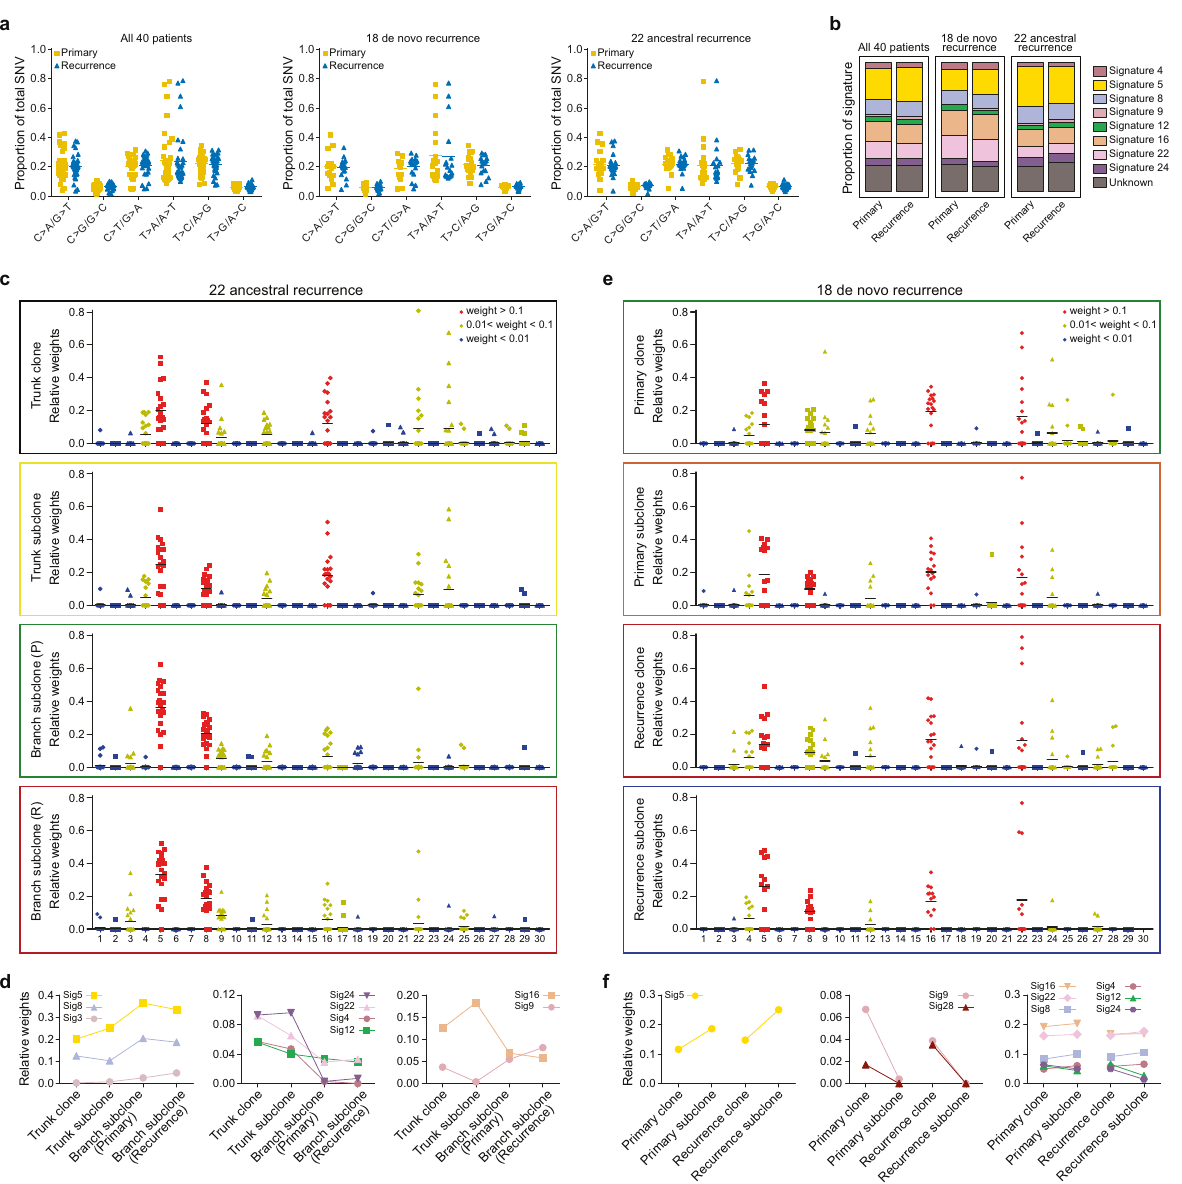
Fig. 5 Mutational spectrum and signatures in primary and early-recurrent HCC. a Six substitution patterns sorted by the total mutation number in primary tumors and recurrent tumors from all 40 patients (left panel), 18 patients with de novo recurrence (middle panel), and 22 patients with ancestral recurrence (right panel). b Major mutational signatures extracted from paired primary and recurrent HCC samples. c Dot plots showing the distribution of mutational signatures to each patient in the trunk clone, the trunk subclone, and primary and recurrence branch subclones from patients with ancestral recurrence, based on our classi fi cation of clonal and subclonal mutation clusters. d Comparison of major mutational signatures across trunk clone, trunk subclone, and primary and recurrence branch subclones in 22 patients with ancestral recurrence. Left panel: mutational signatures with elevated proportions; middle panel: mutational signatures with decreased proportions; right panel: mutational signatures with variable proportions. e Dot plots showing the distribution of mutational signature to each patient in the clone and subclone of the primary or recurrent tumor, respectively, from the patients with de novo recurrence, based on our classi fi cation of clonal and subclonal mutation clusters. f Comparison of major mutational signatures across clone and subclone in primary tumors or recurrent tumors, respectively, from patients with de novo recurrence. Left panel: mutational signatures with elevated proportions; middle panel: mutational signatures with decreased proportions; right panel: mutational signatures with maintained proportions heterogeneity between paired regions from primary and recurrent Supplementary Table 15). Tumor ploidy analysis revealed that HCCs, respectively. In three of the four patients (P42, P44, and WGD occurred in all of the tumors from patient P51 and all of the P51), we observed substantially higher temporal heterogeneity recurrent tumors from patient P44 (Supplementary Fig. 12a). than spatial heterogeneity (Fig. 6a), which was consistent with the We explored the spatial and temporal tumor heterogeneity Jaccard similarity coef fi cient results (Supplementary Fig. 12c). based on somatic mutations (SNVs + indels) at the whole-genome We constructed phylogenetic trees, analyzed the subclonal level. We de fi ned spatial heterogeneity as intra-tumoral hetero- architectures, and displayed evolutionary processes using fi shplot geneity between paired regions within primary or recurrent (Fig. 6a – c; Supplementary Figs. 13 – 17; Supplementary Tables 16 tumors. We de fi ned temporal heterogeneity as inter-tumoral Signal Transduction and Targeted Therapy (2022)